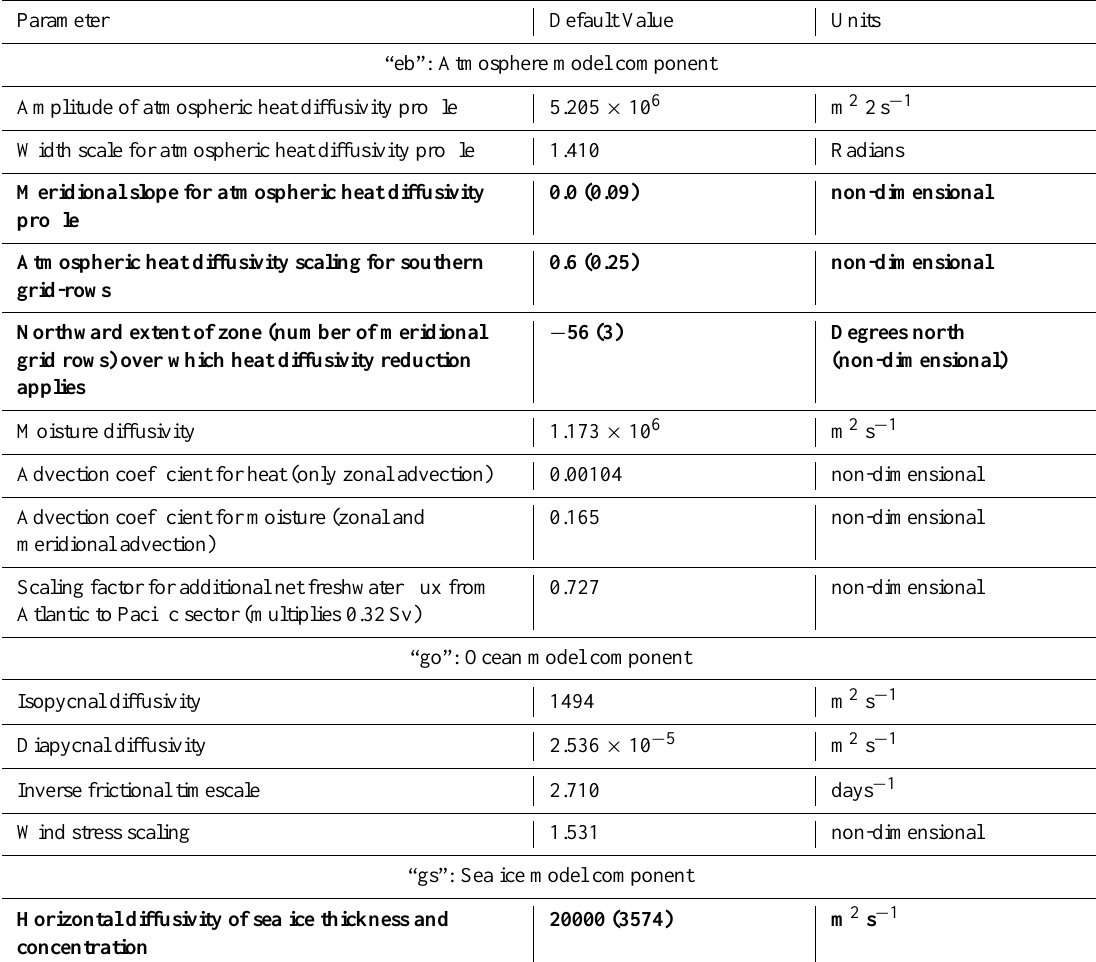
Table 3. Values of key parameters for the model components used for the five spin-up simulations. With the exception of a few modified parameters (bold typeface), the parameter values are identical to those listed for “GENIE-16” by Cao et al. (2009) (in the appendix and supplementary material). For “biogem”, the original values as reported by Cao et al. (2009) (listed in parentheses) have been